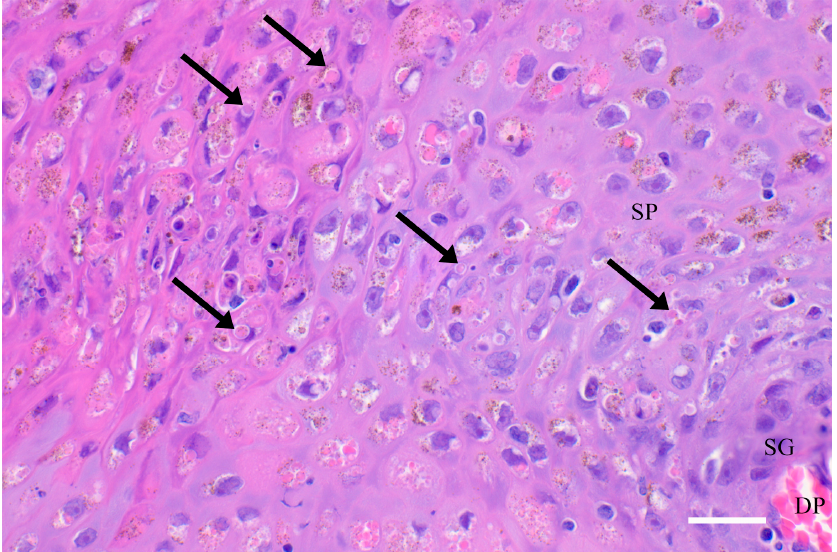
Figure 3. Histology and ultrastructure. Skin from a harbour porpoise ( Phocoena phocoena ) stranded along the coast of northern California with tattoo skin disease, showing a dermal papilla (DP) with capillaries, the stratum germinativum (SG) and part of the stratum spinosum (SP). Acanthocytes in the SP contain amphophilic cytoplasmic inclusion bodies (arrows). Hematoxylin & Eosin stain, 400x magnification, scale bar = 50 µ